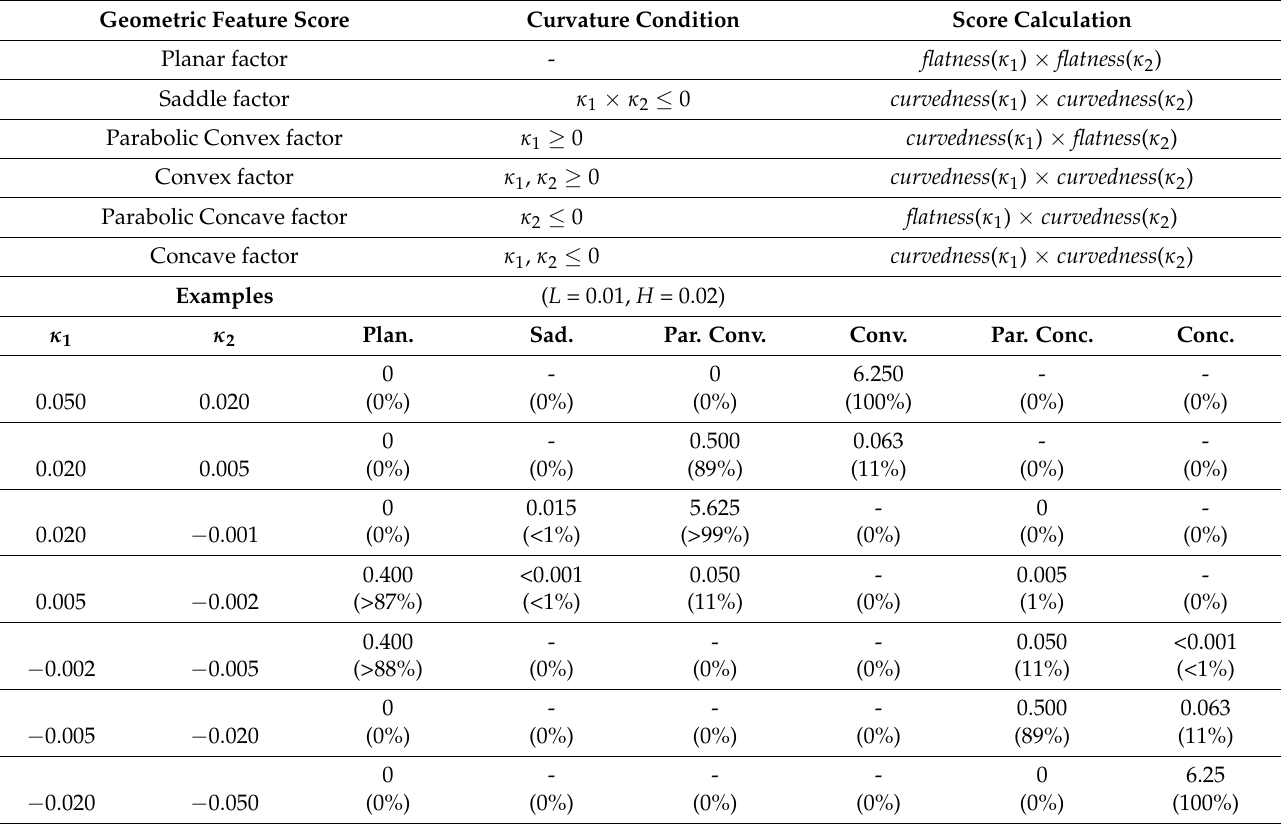
Table 2. Calculation of curvature based geometric